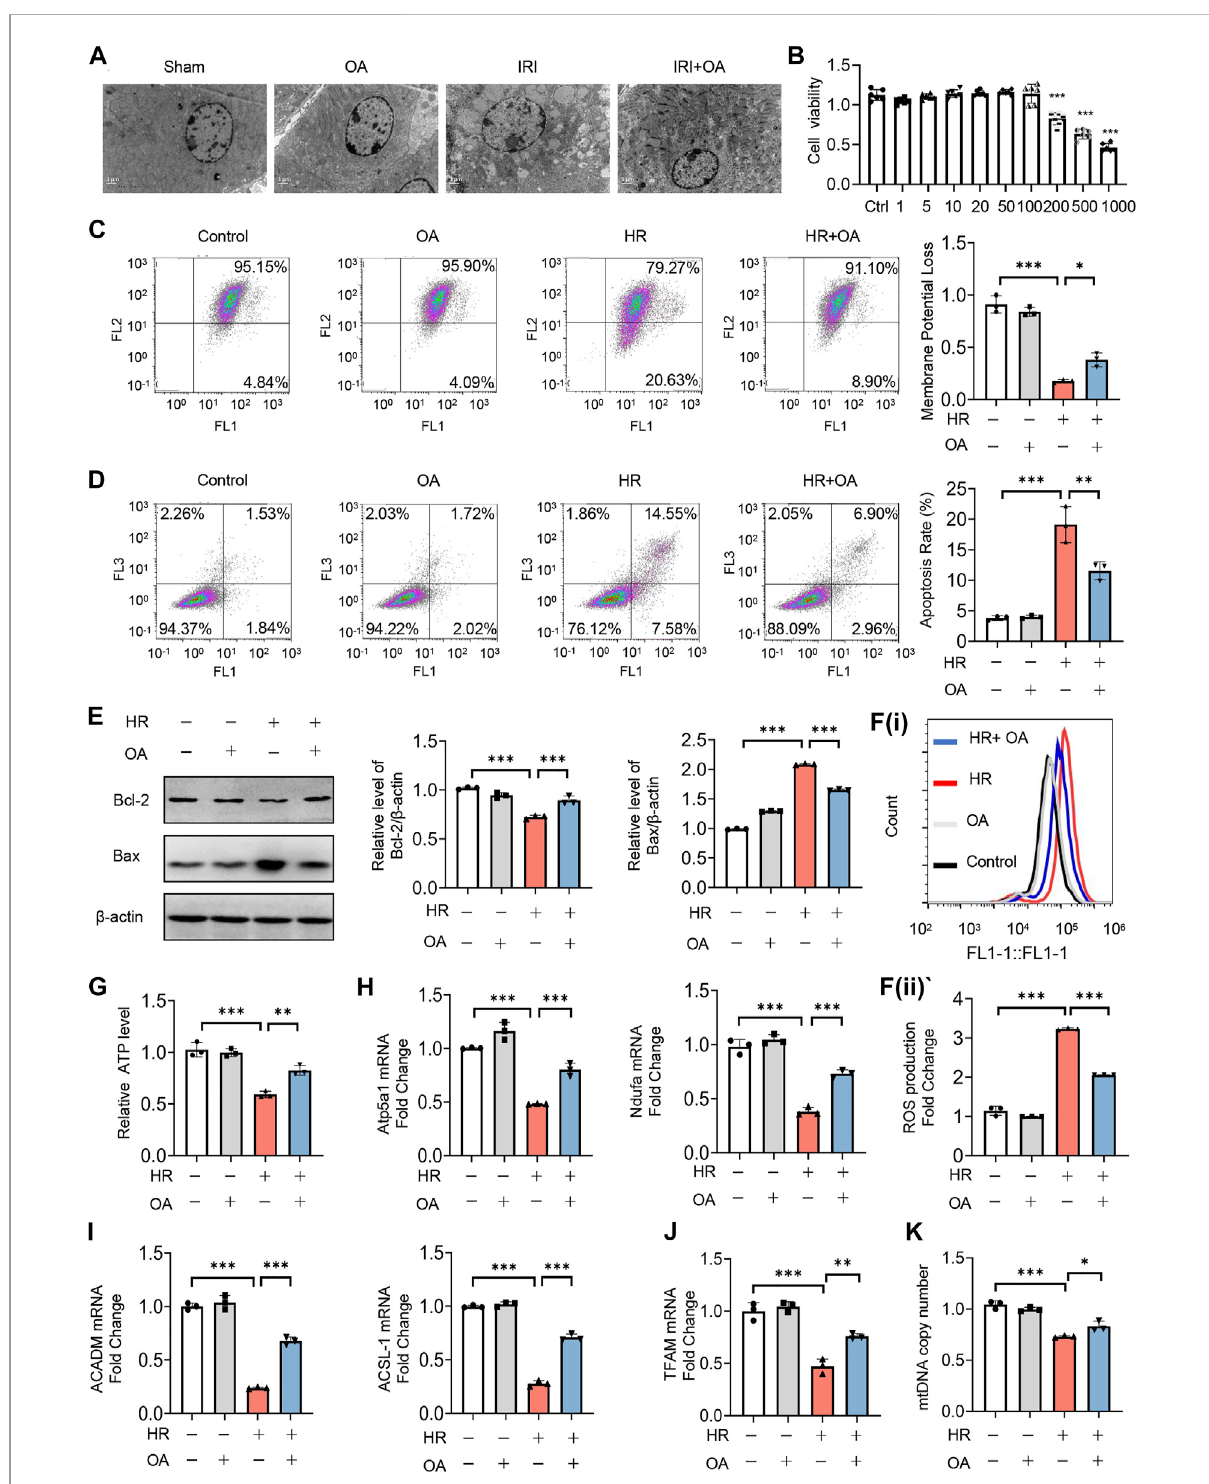
FIGURE 2 OAameliorateshypoxia-reoxygenation(HR)-mediatedmitochondrialhomeostasisimbalance invitro . (A) RepresentativeTEMimagesofkidney tissues from sham and AKI mice treated with control or OA (20 mg/kg) for 24 h. Scale bar, 1 μ m. (B) Cell viability of HK-2 cells incubated with indicatedconcentrationsofOAfor 48 hwasdeterminedusingCCK-8. (C – I) HK-2 cellsunderHRexposureweretreatedwithcontrolorOA(10 μ M), then the mitochondrial membrane potential (C) , apoptosis (D , E) , ROS (F) , ATP (G) , the expressions of Atp5a1, Ndufa, ACADM and ACSL-1 (H , I) were analyzed ( n = 3). (J , K) HK-2 cells under HR exposure were treated with control or OA (10 μ M), the expression of TFAM (J) and